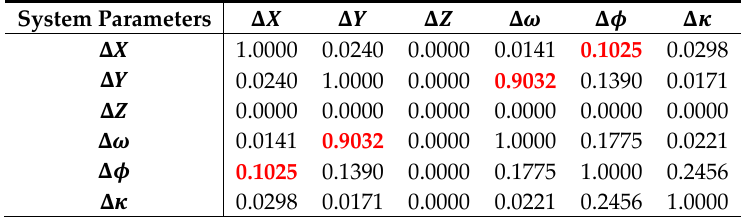
Table 5. Correlation matrix of mounting parameter estimates from calibration test 2 (the potential high correlation values are shown in red).